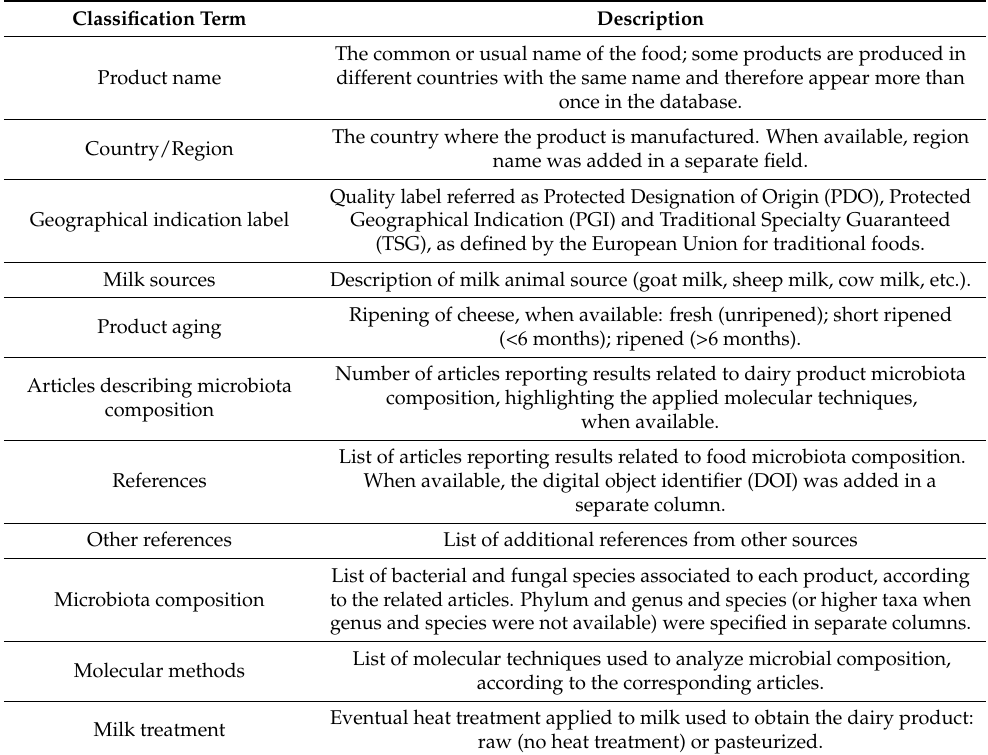
Table 1. Classification terms through which the different fermented dairy products were categorized in the database. Each searched item is a dedicated column in the